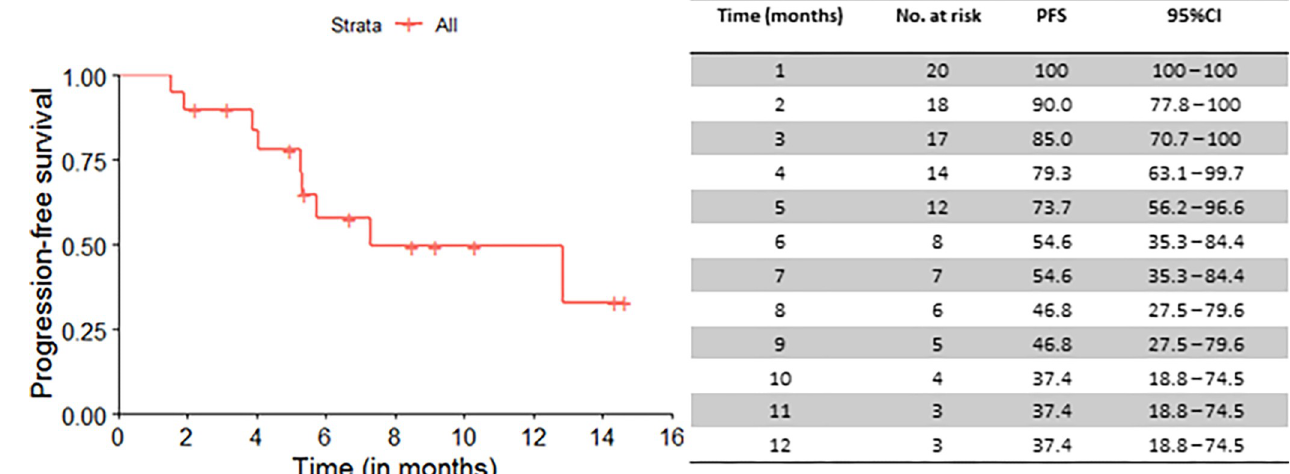
PLOS ONE | https://doi.org/10.1371/journal.pone.0278950 December9,